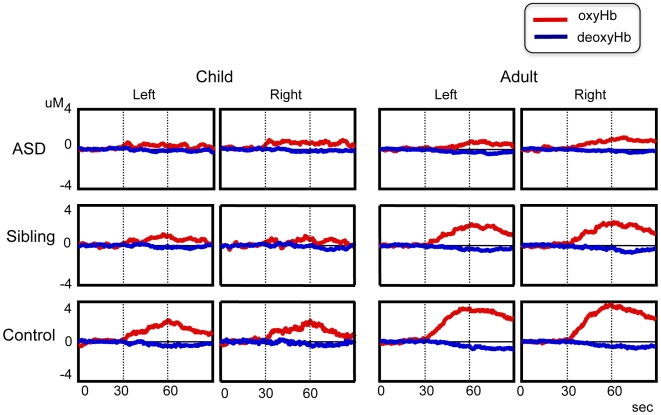
Grand average waveforms of hemoglobin concentration changes during the letter fluency task.Top: Autism spectrum disorder, Middle: Unaffected siblings, bottom: healthy control, right: adult group, left: child group. Line: red, oxyhemoglobin; blue, deoxyhemoglobin. The period of the activation task is between two dot-lines.